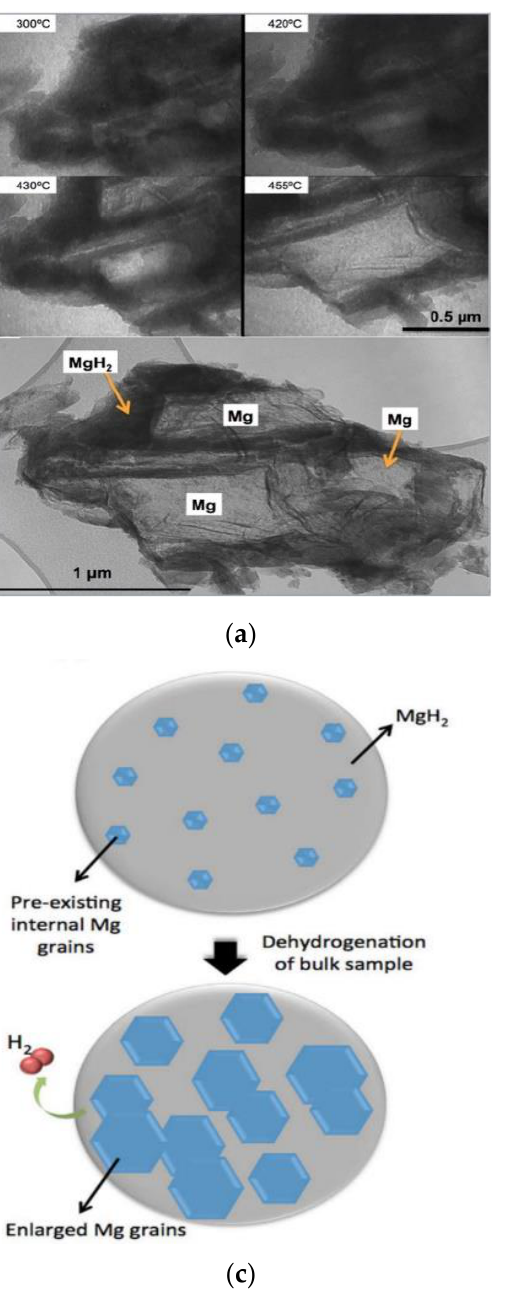
Figure 3. ( a ) Selected still frame TEM images from in situ video of high voltage (1000 kV) TEM of a ~ 2 μm bulk MgH 2 particle taken at 300 °C, 420 °C, 430 °C, and 455 °C, and a low magnification bright field image of the sample (a single bulk powder particle) at 455 °C (bottom) [55]; ( b ) Selected still frame TEM images from in situ videos of conventional (200 kV) TEM through a thinned region (a few tens of nm) of an MgH 2 particle taken at 50 °C, 150 °C, 250 °C, and 380 °C [55]; ( c ) Schematic multiple “ nucleation and growth ” hydrogen release mechanisms for bulk MgH 2 grains [55]; ( d ) Schematic “ shrinking core ” hydrogen release mechanisms for thin MgH 2 TEM samples [55].